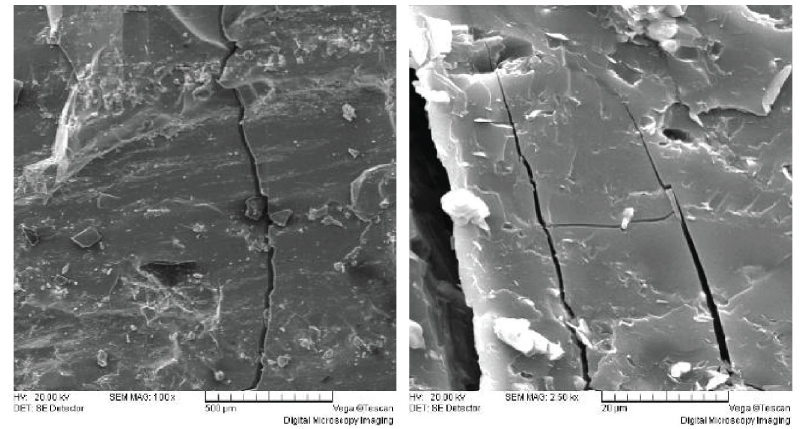
Figure 1: Original image of the coal sample containing cracks.